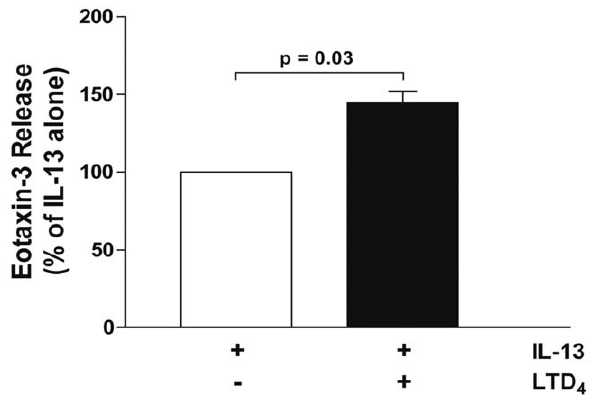
Figure 6. Effect of LTD 4 on eotaxin-3 release by airway epithelial cells pretreated with IL-13. After a 6 hour incubation of airway epithelial cells with 10 ng/ml IL-13, cells were further cultured for an additional 18 hours in the presence or absence of 100 nM LTD 4 . Incubations were stopped by removing the supernatants and eotaxin-3 was quantified as described in Material and Methods . The data represent the mean ( 6 SEM) of three independent experiments.